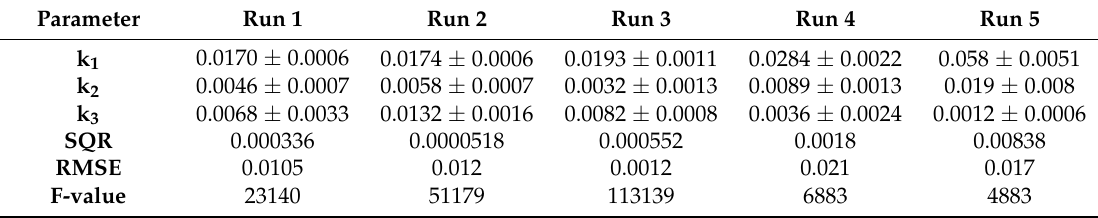
Table 1. Kinetic and goodness-of-fit parameters for the proposed model and the different runs. Parameter Run 1 Run